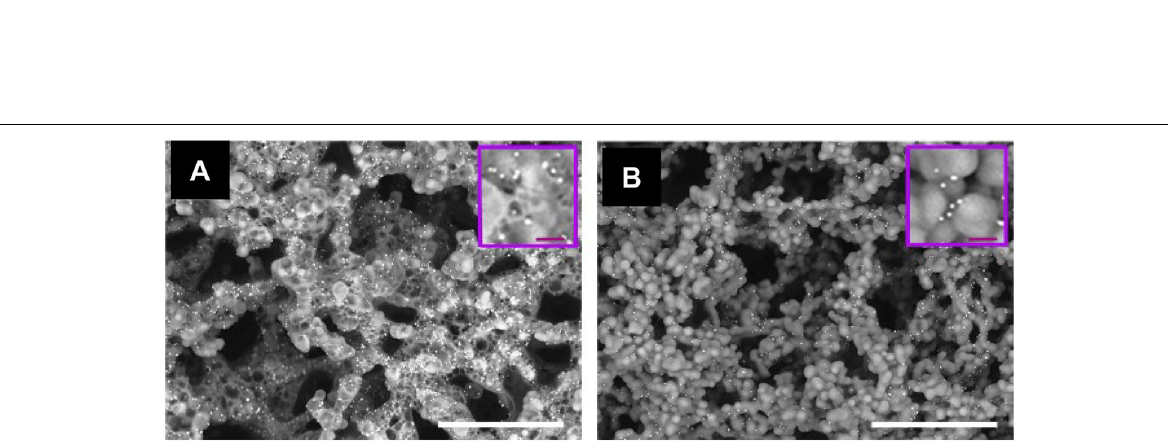
15 μm. Insets magnified views (bars 600 nm). From Kawasaki et al. 2021 with permission from = = =